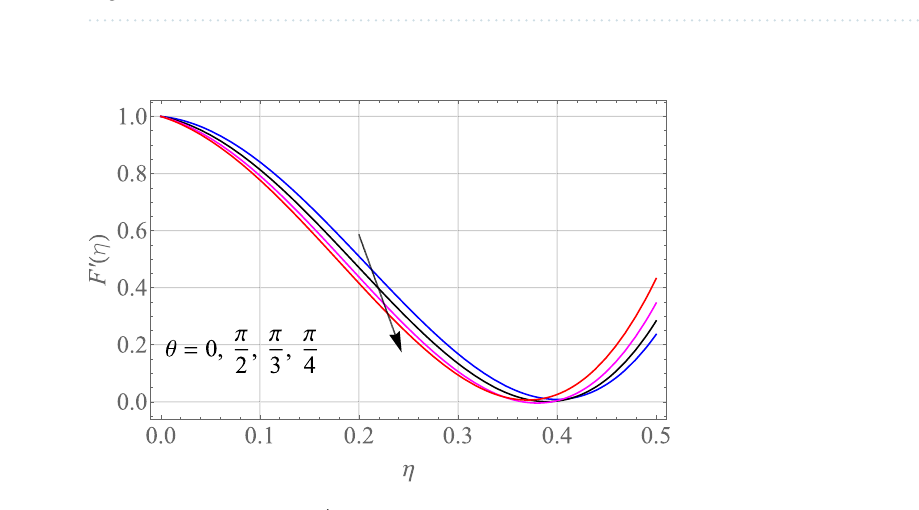
Figure 3. Alterations in F ′ (η) as S raises. When M = 0.1, Pr = 6.2, Gr = Gc = 0.2, Ec = 1, Nb = Nt = 0.3, Sc = 0.3 .